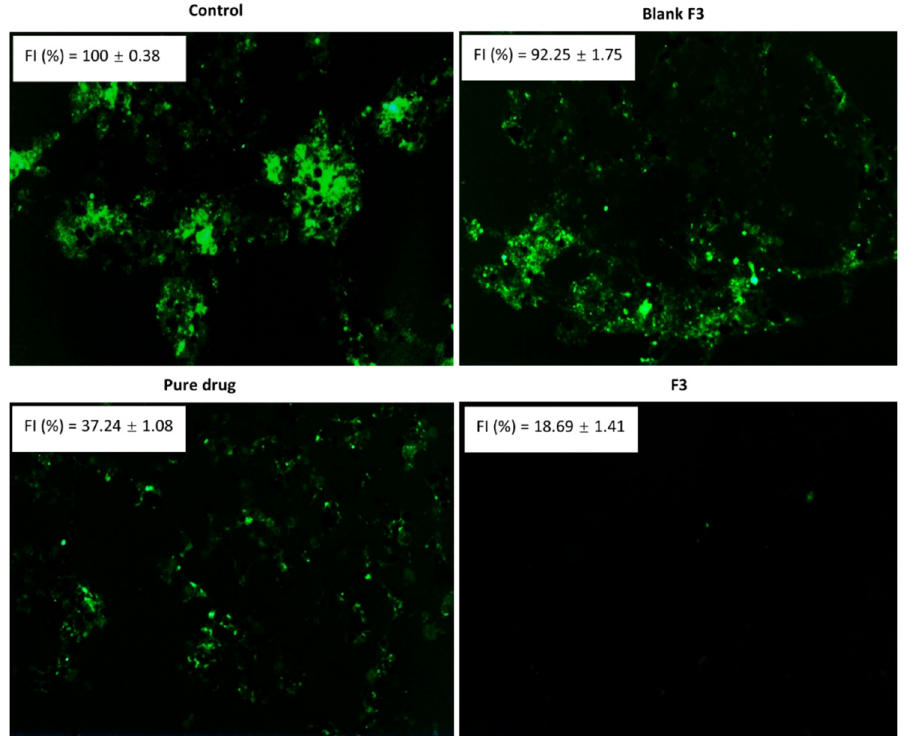
Figure 8. The intracellular ROS level determined by H 2 DCFDA in NIH3T3 cells. (FI = fluorescence